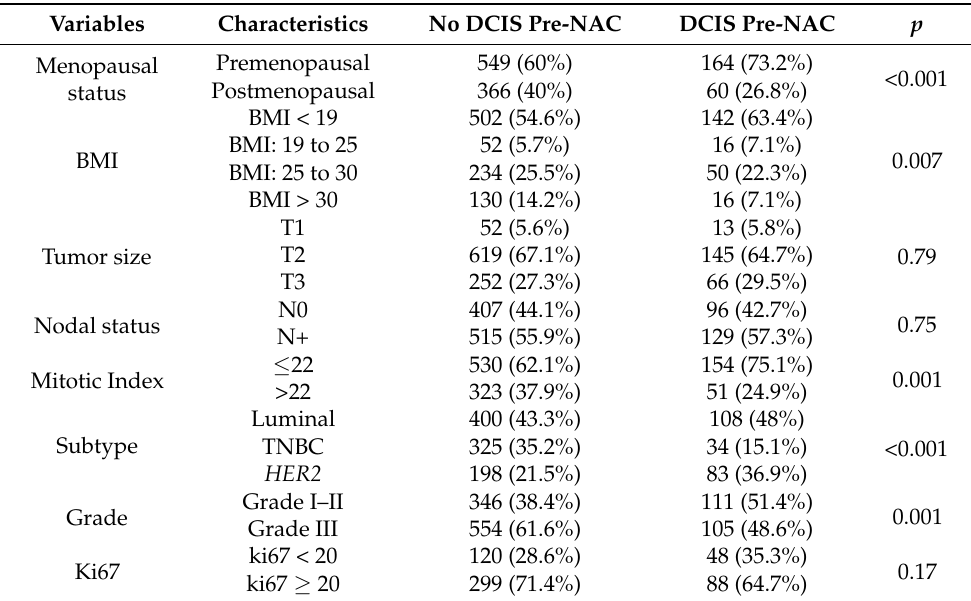
Table 2. Association between the characteristics of patients and tumors and the presence of pre- NAC